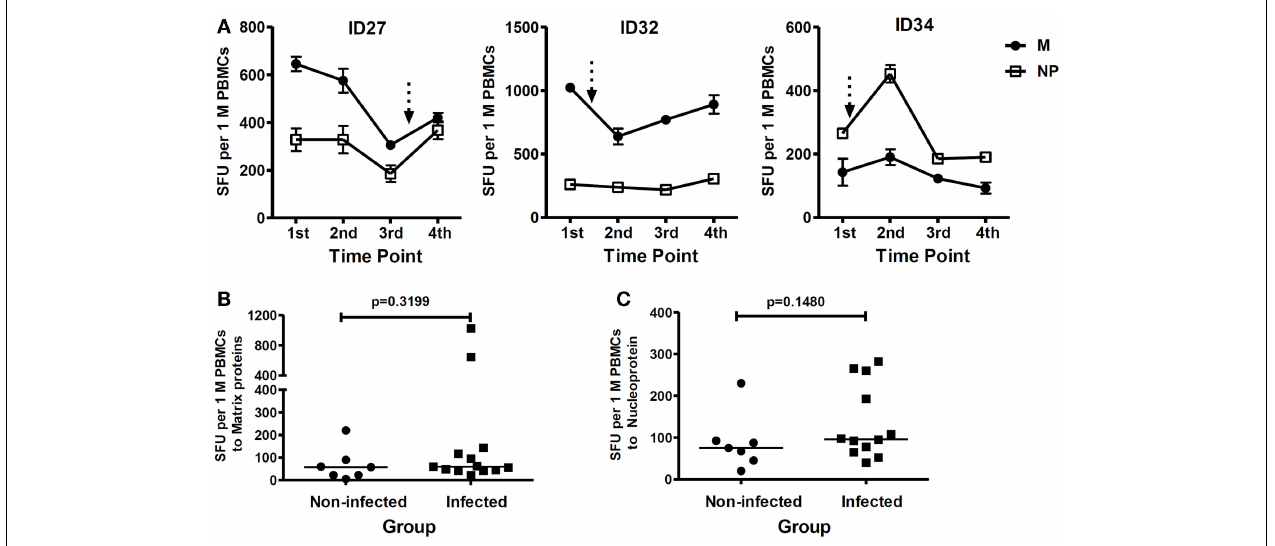
un-infected ( n = 7) study subjects. (C) Comparison of pre-existing cross-reactive T cell responses targeting NP protein between the vaccine virus-infected ( n = 12) and un-infected ( n = 7) study subjects. Study subject ID29 was excluded because of limited cell numbers . p- values were calculated using the Mann–Whitney test. For the scatter dot plots (B,C) , the line represents the median